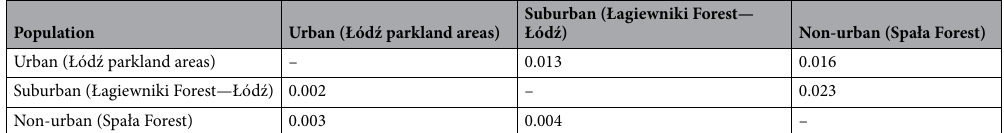
Population Urban (Łódź parkland areas)